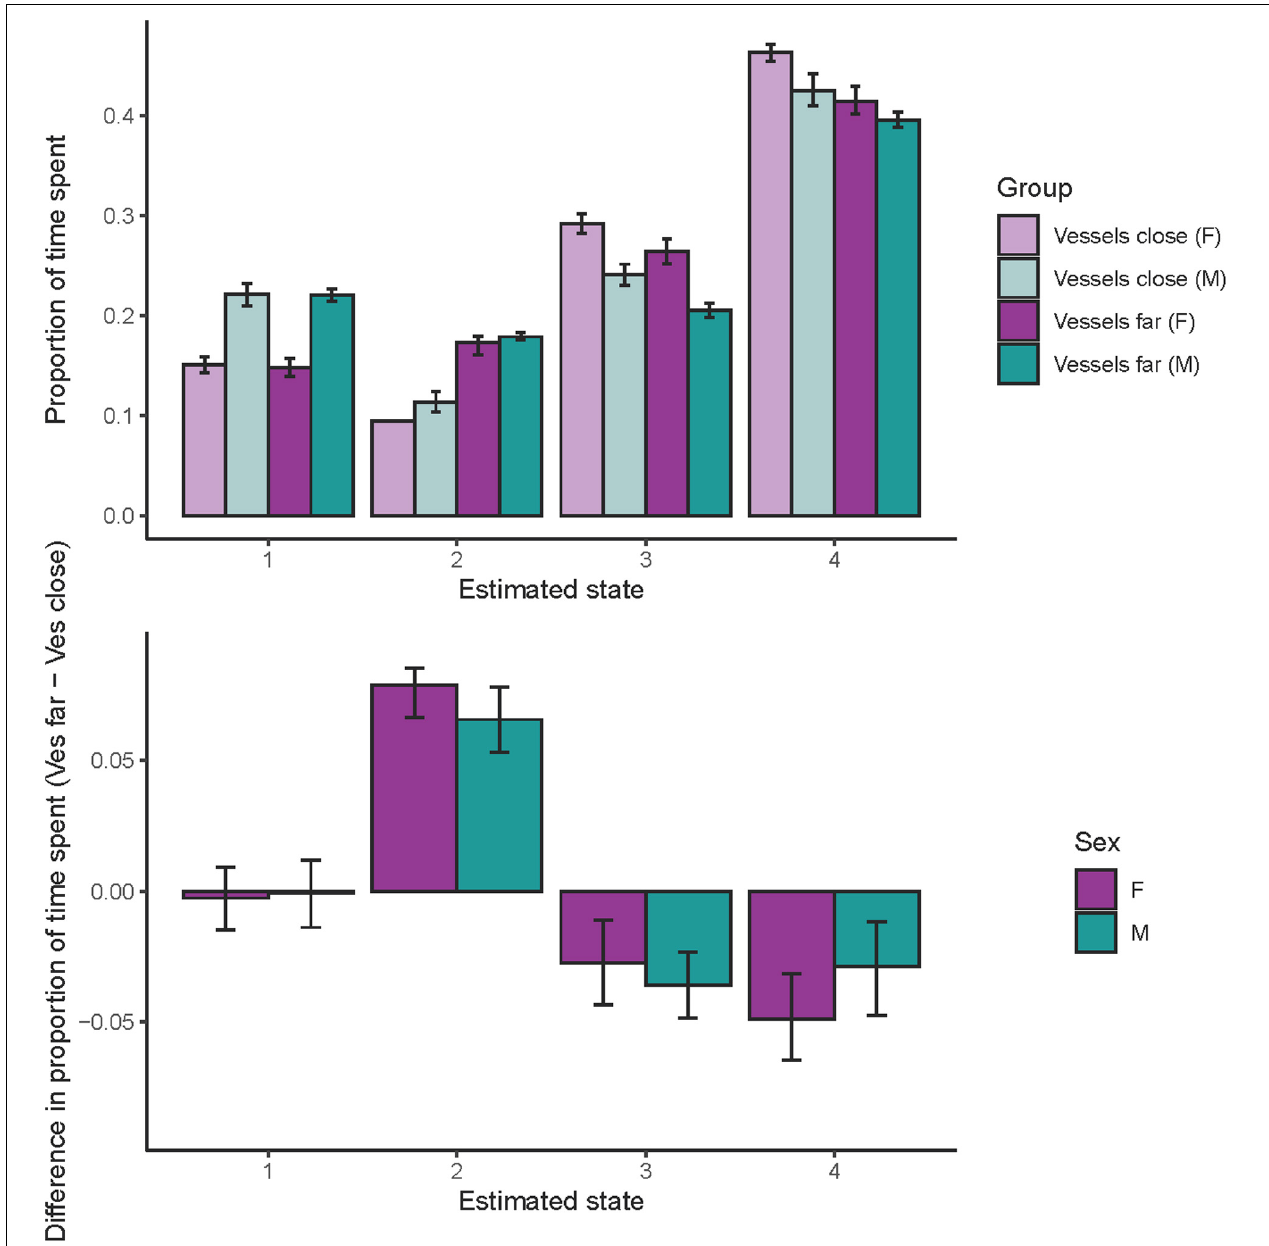
FIGURE 4 | Proportion of time spent in each state. Top panel: proportion of time spent in each state by sex and vessel distance, light purple = females with close vessels, dark purple = females with far vessels, light teal = males with close vessels, and dark teal = males with far vessels. Bottom panel: difference in the proportion of time spent in each state with vessel distance (proportion of time with far vessels minus proportion of time with close vessels) for both sexes. Error bars in both plots indicate the 95% credible interval.